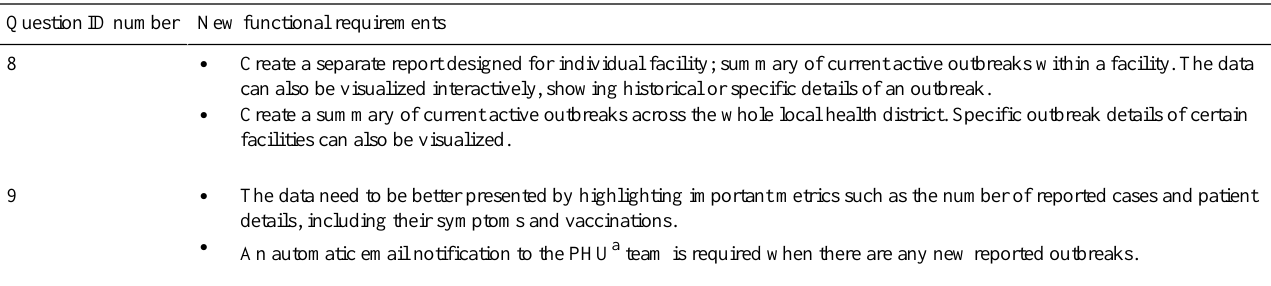
Table 4. The list of changes to functional requirements based on the exposure of prototypes to